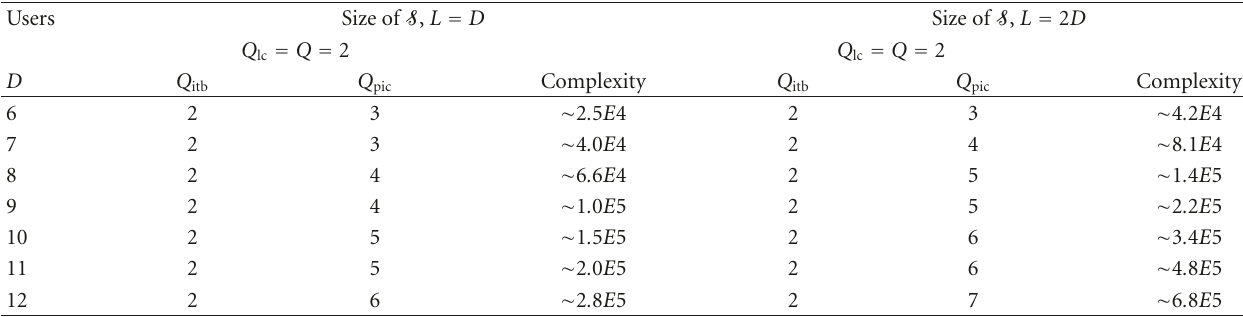
Table 1: Parameters and complexity for PD-IE simulations in Figures 7 and 8 using an M = 5-element UCA. Users